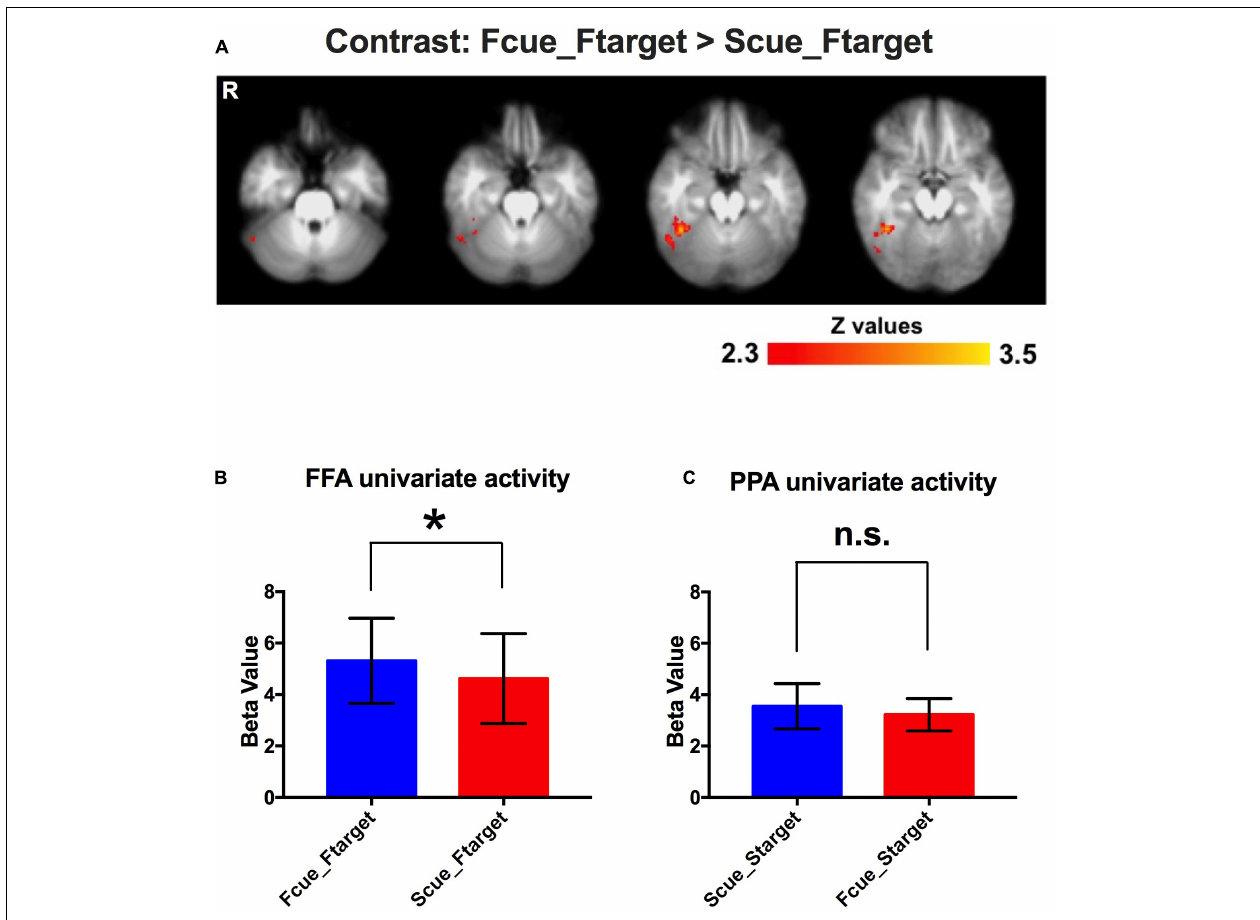
FIGURE 3 | Event-related fMRI results. (A) A significantly activated region in the fusiform gyrus for the contrast of Fcue_Ftarget > Scue_Ftarget. Statistical threshold was set at Z > 2.3 and p < 0.05, FDR corrected at cluster level. (B,C) Univariate activities of FFA and PPA in different conditions. Univariate FFA activity during WM maintenance period was increased when the cue pointing to a face, compared to that when the cue pointing to a scene (Fcue_Ftarget > Scue_Ftarget; p = 0.022). For univariate PPA activity, there was no significant difference between groups of Scue_Starget and Fcue_Starget ( p = 0.16). The symbols ( ∗ ) and (n.s.) indicate being and not being significant,